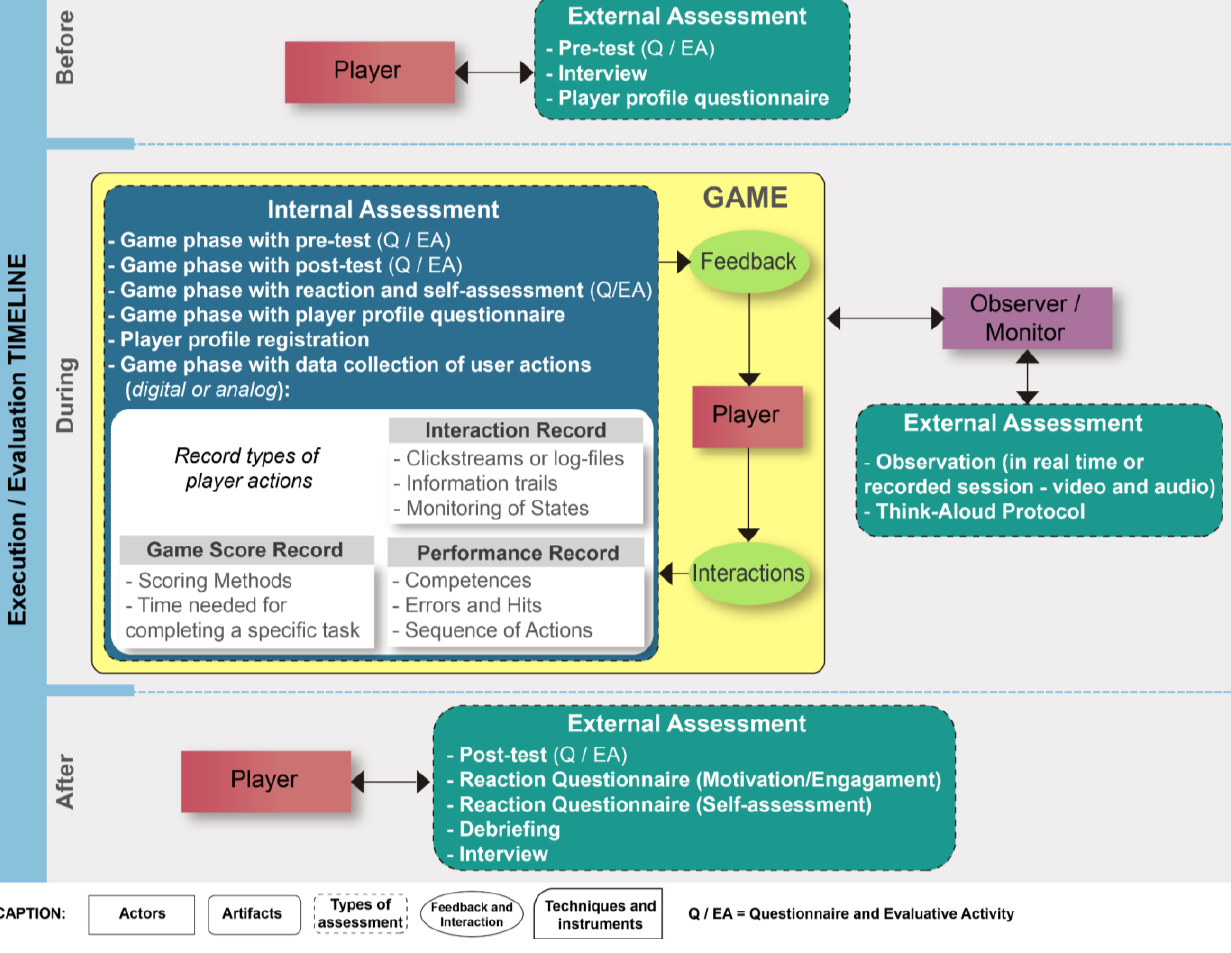
Figure 2. Detailed overview of the execution/evaluation step of the AvaliaJS